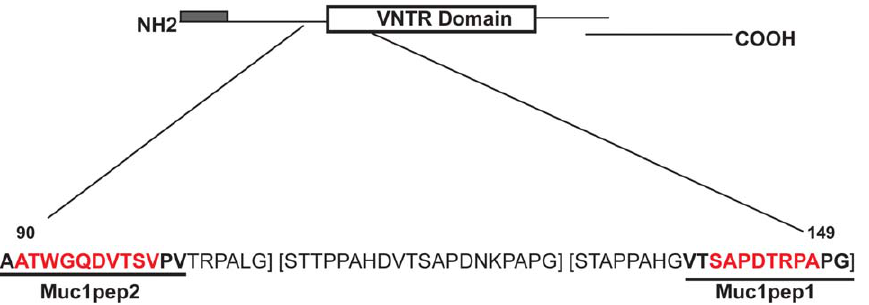
Figure 1. Structure of the MUC1 protein. The secretory signal peptide is shown as a shaded box at the N-terminus. The variable number tandem repeat (VNTR) is shown as an open rectangle. The small C-terminal domain, which is proteolytically derived from a common precursor protein and containing the transmembrane domain is also shown. The expanded region shows the amino acid sequences of three VNTR repeats [in brackets]. The amino acid sequences of the 12-mer and 14-mer peptides (MUC1pep1 and MUC1pep2 respectively) used for biopanning are underlined. The sequence of the core peptides used for eluting bound phage, competition ELISA and DC stimulation are shown in red.